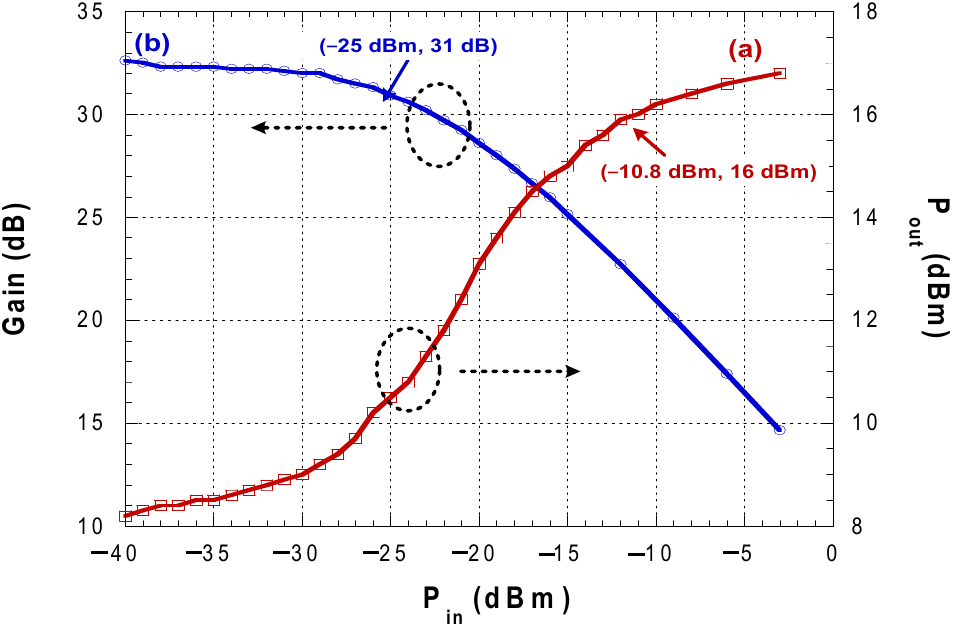
Figure 13. Experimental results for the EDFA in ROA 3 : curve ( a ) backward-pumping configuration and curve ( b ) forward-pumping configuration.